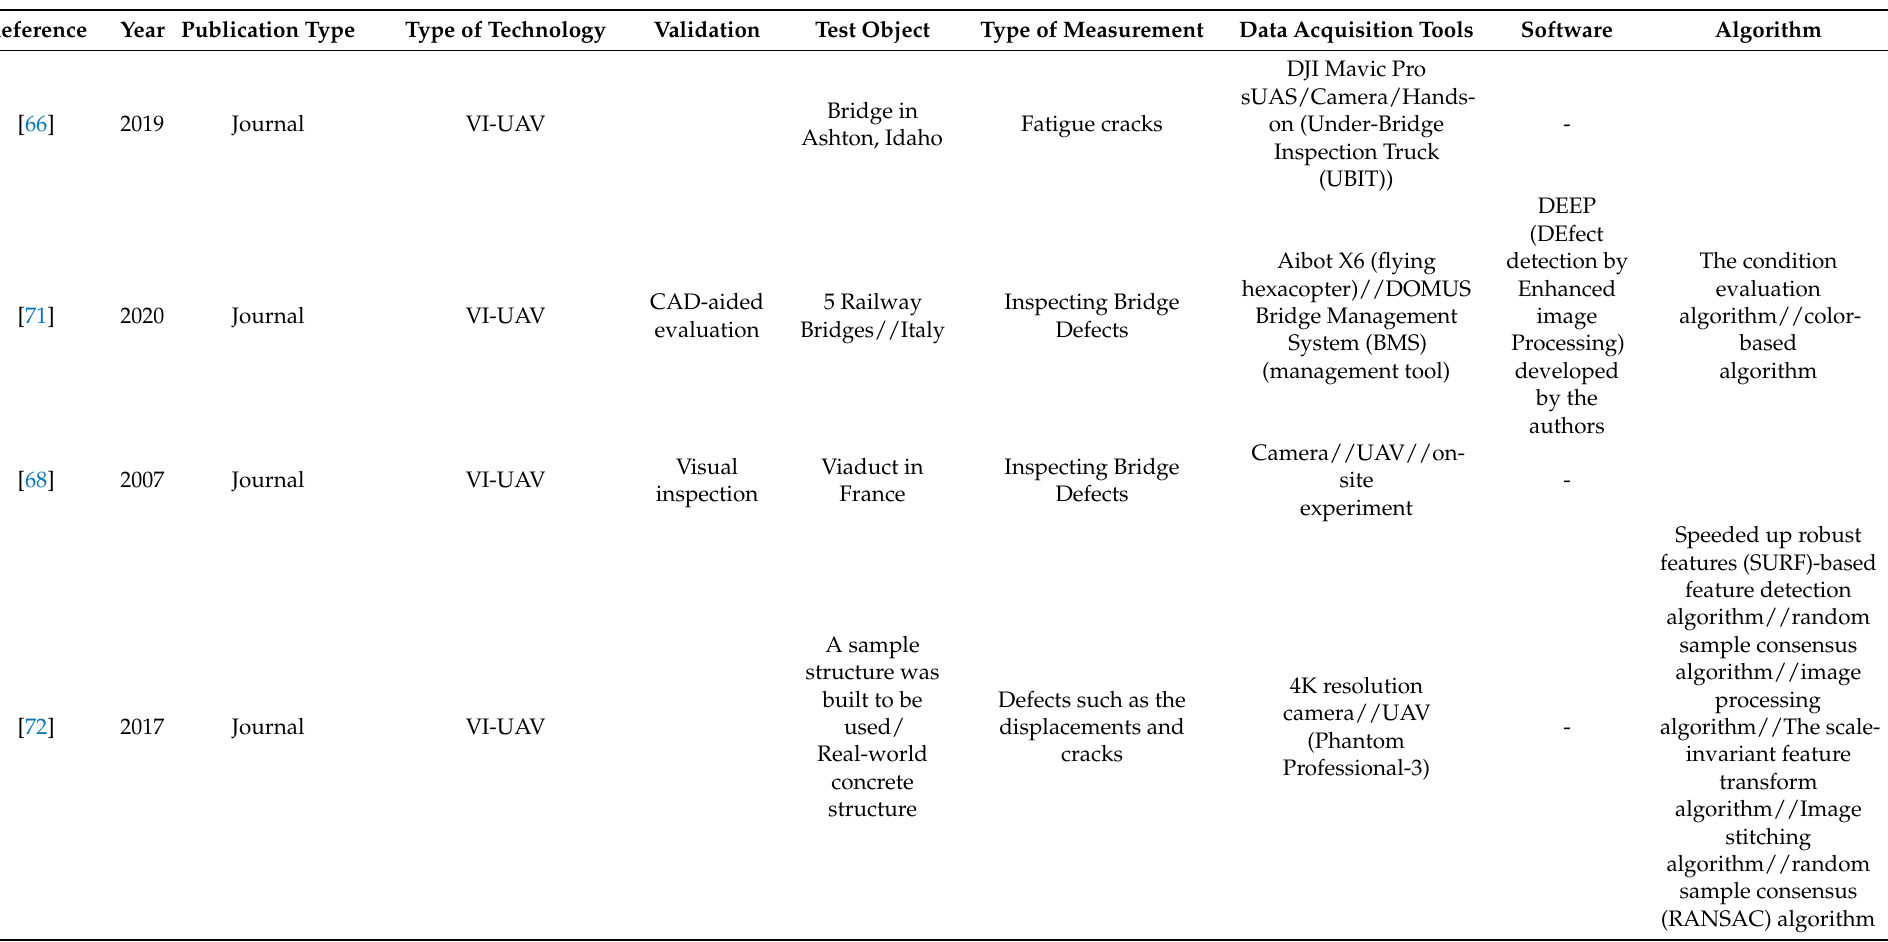
Table A1. Summarized research data extracted from selected